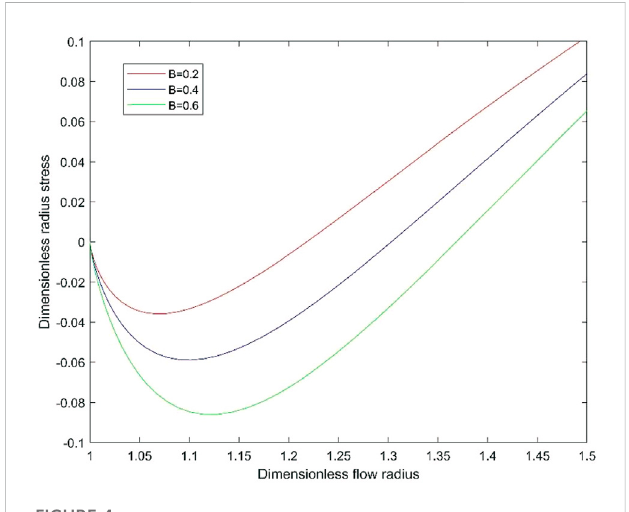
FIGURE 4 The effective radial stress distribution in the acceleration fl ow for various B